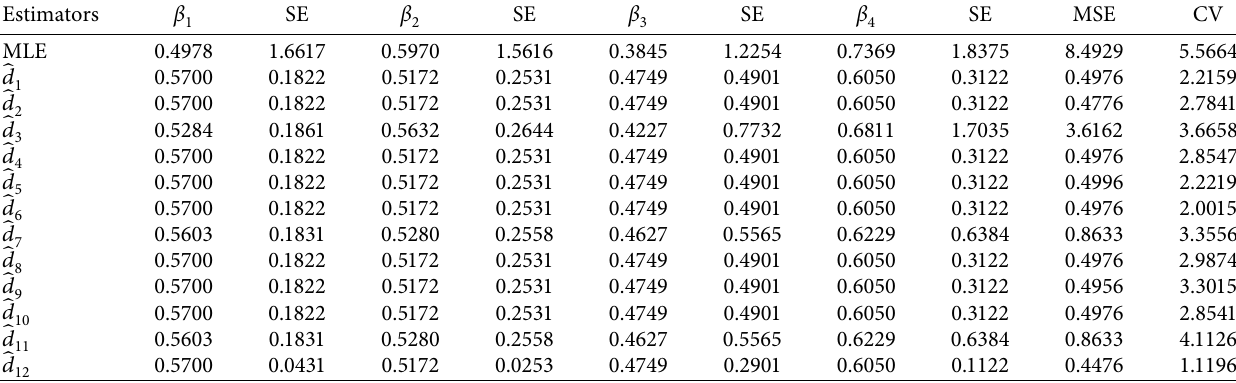
Table 13: Estimated coefficients, standard errors, and MSE values, COMPRM estimators for Plywood data. Estimators β 1